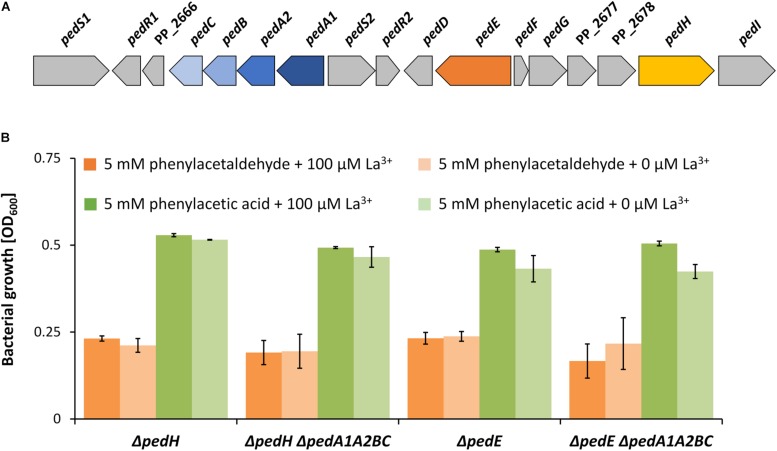
(A) Genomic organization of the ped cluster in Pseudomonas putida KT2440. Nomenclature in analogy to P. putida U as suggested by Arias et al. (2008). (B) Growth of ΔpedH, ΔpedHΔpedA1A2BC, ΔpedE, and ΔpedEΔpedA1A2BC strains in liquid M9 medium with TES on 5 mM phenylacetaldehyde (orange bars) or 5 mM phenylacetic acid (green bars) and either 0 μM La3+ (dark green and dark orange bars) or 100 μM La3+ (light green and light orange bars). OD600 was determined upon 48 h of incubation at 30°C and 180 rpm. Data are presented as the mean values of biological triplicates and error bars represent the corresponding standard deviations.